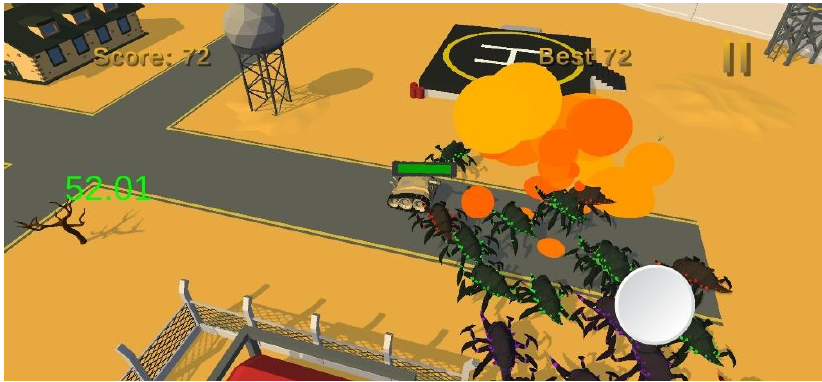
Figure 16. Snapshot after the elimination of 72 enemies in the optimized version of the game.